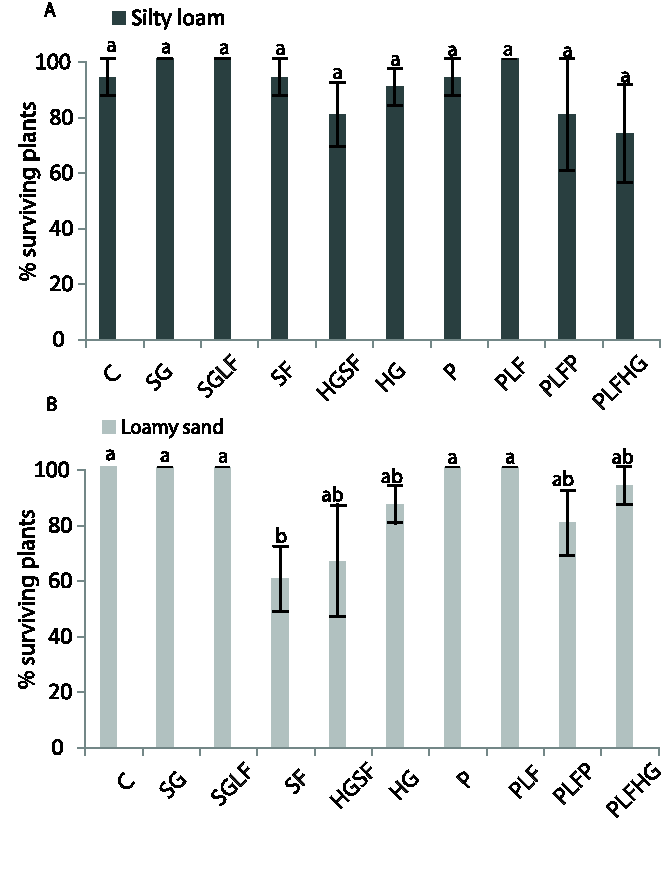
Figure 1. Effect on seedling survival after direct application of fertilizers, hydrogel or the combination of substrates. ( A ) Seedling survival at the silty loam site; ( B ) seedling survival at the loamy sand site. The treatments consisted of no treatment (C), starch gel (SG), starch gel containing liquid fertilizer (SGLF), solid fertilizer (SF), hydrogel (HG), hydrogel containing solid fertilizer (HGSF), Perlite (P), Perlite containing liquid fertilizer (PLF), Perlite containing liquid fertilizer diluted with fertilizer-free Perlite (PLFP) and Perlite containing liquid fertilizer and hydrogel (PLFHG). Cutting mortality was recorded at the end of the first growth season. Data shown are the percentage of survived cuttings as a mean value of n = 3 and standard error. Means with the same letter are not significantly separated at the p = 0.05